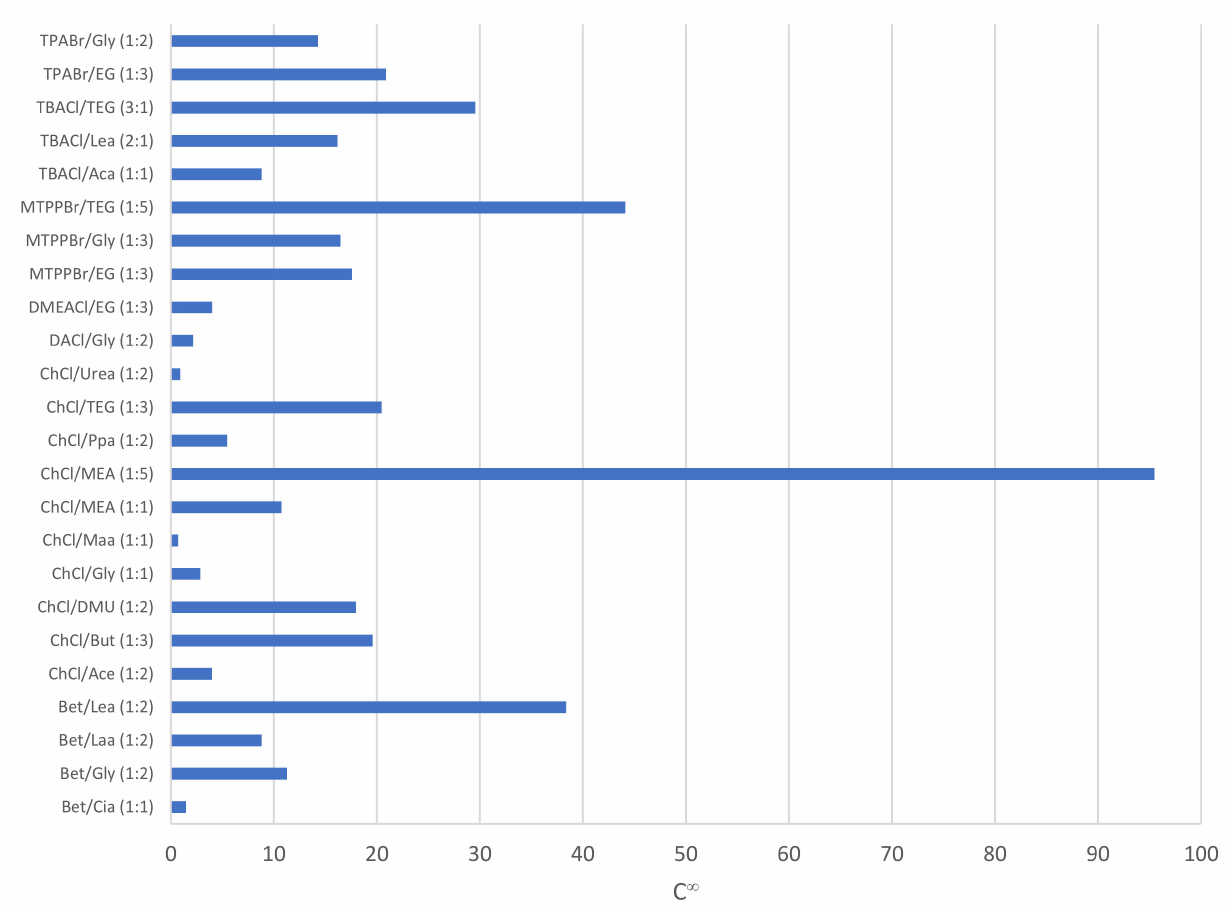
Figure 2. Capacity of phenol in various